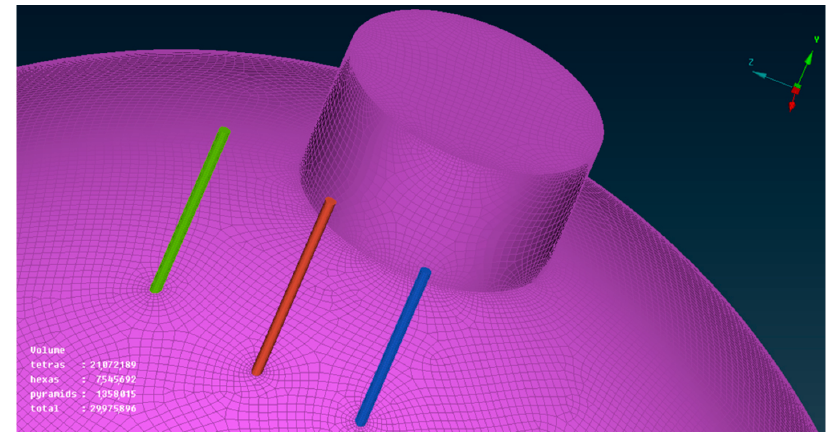
Figure 4. Overall model grid diagram.